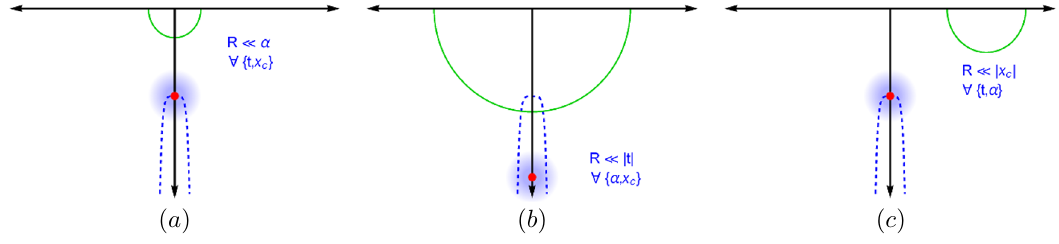
Figure 9 . Bulk illustration of the cases where the ‘(cid:12)rst law’-like relation (4.52) is expected to hold: ( a ) R (cid:28) (cid:11) and 8 f t; x c g , ( b ) R (cid:28) t and 8 f (cid:11); x c g or ( c ) R (cid:28) x c and 8 f t; (cid:11) g . For all of them, one can check that h T 00 ( t; ~x ) ij A ’ E ( t ) is indeed a good approximation so (4.52) follows directly from